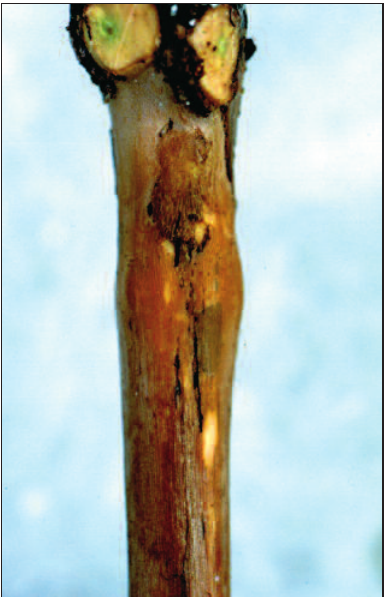
Figure 10 . Kober stem grooving (GVA) symptoms on Kober 5BB: grooves around the woody cylinder of the indicator